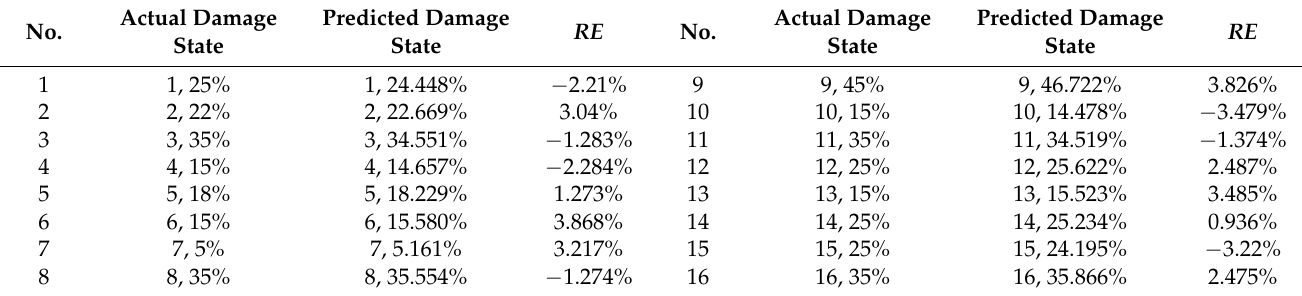
Table 9. Comparison between prediction value and actual value of SCR damage